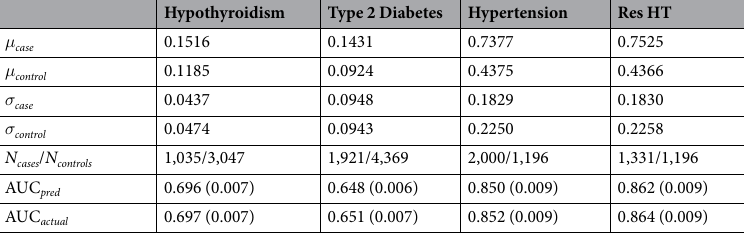
Table 6. Mean and standard deviation for PGS distributions of cases and controls, using predictors built from SNPs, sex, and age, and trained on case-control status alone. Predicted AUC from assumption of displaced normal distributions and actual AUC are also